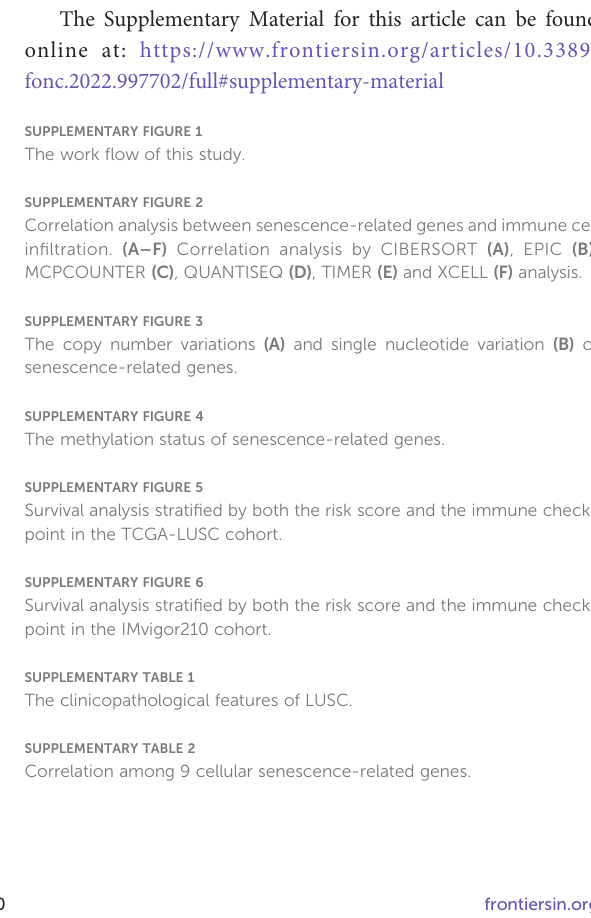
SUPPLEMENTARY TABLE 2 Correlation among 9 cellular senescence-related